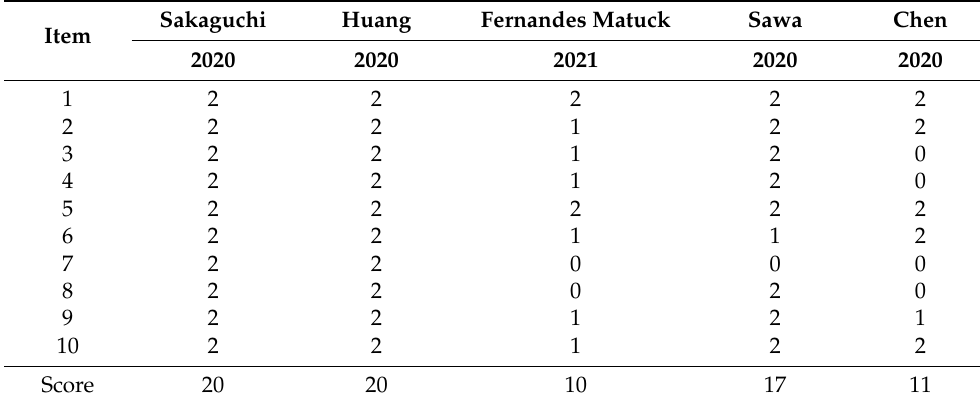
Table 2. Quality assessment of the reports included in this systematic review.